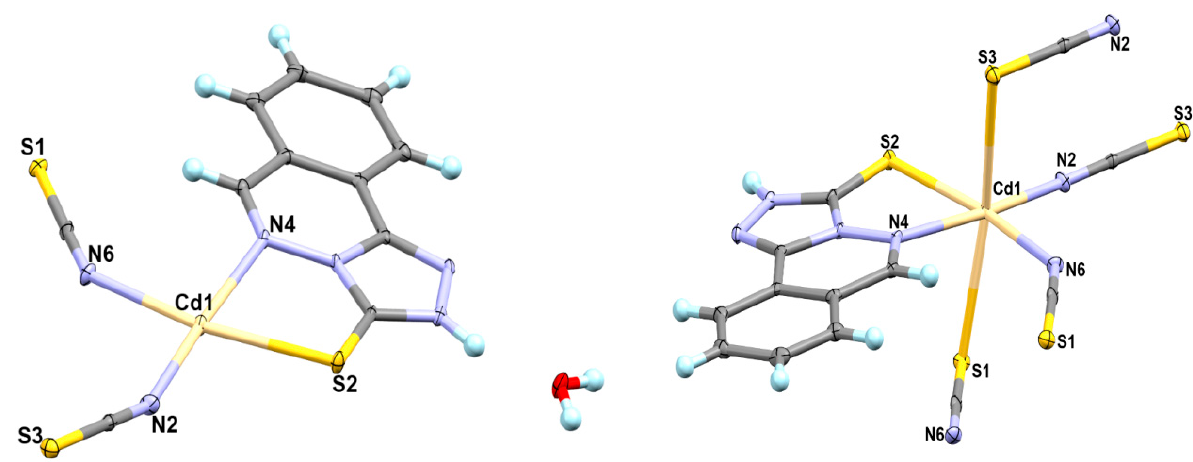
Figure 6. Asymmetric unit ( left ) and coordination sphere ( right ) with atom numbering for 2 . Table 4. Bond distances (Å) and angles °) for 2 .